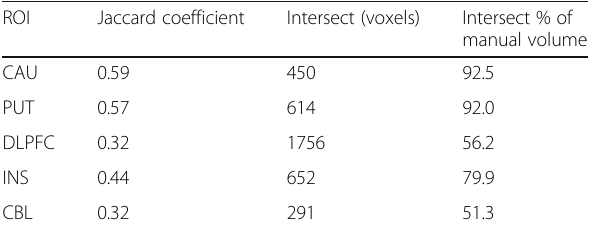
Table 1 Jaccard coefficients obtained by comparison of ROIs made manually and by